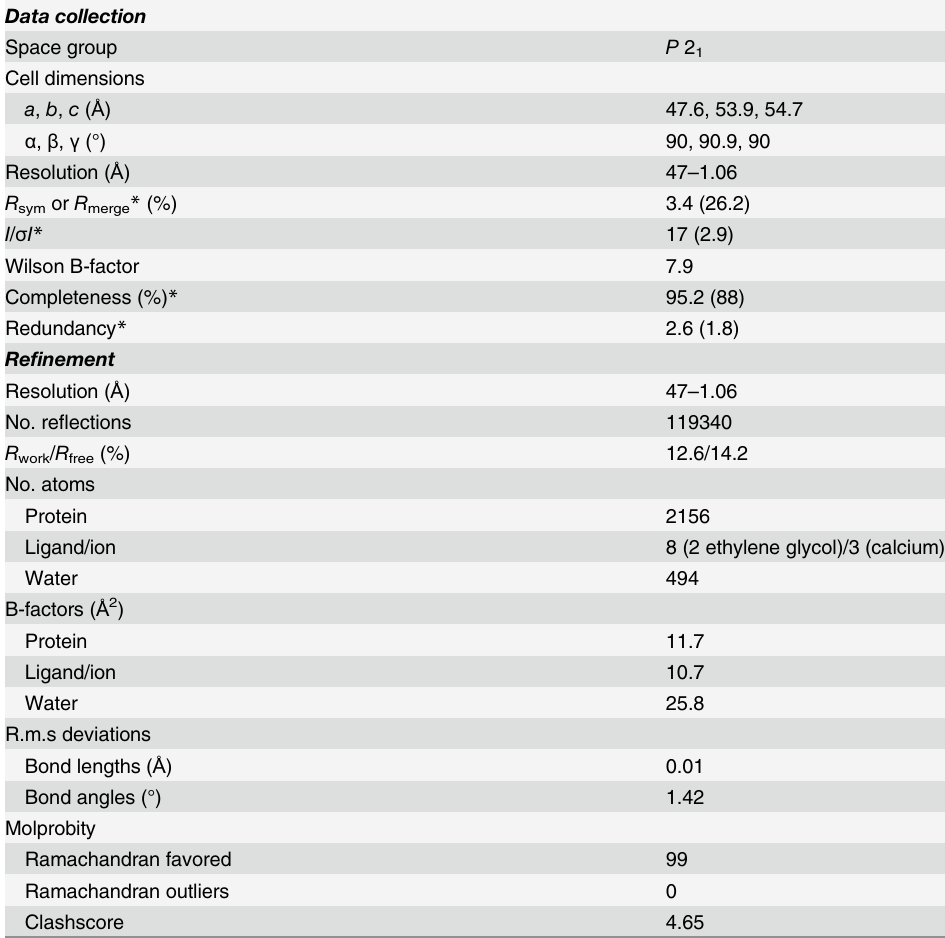
Table 1. Data collection and refinement